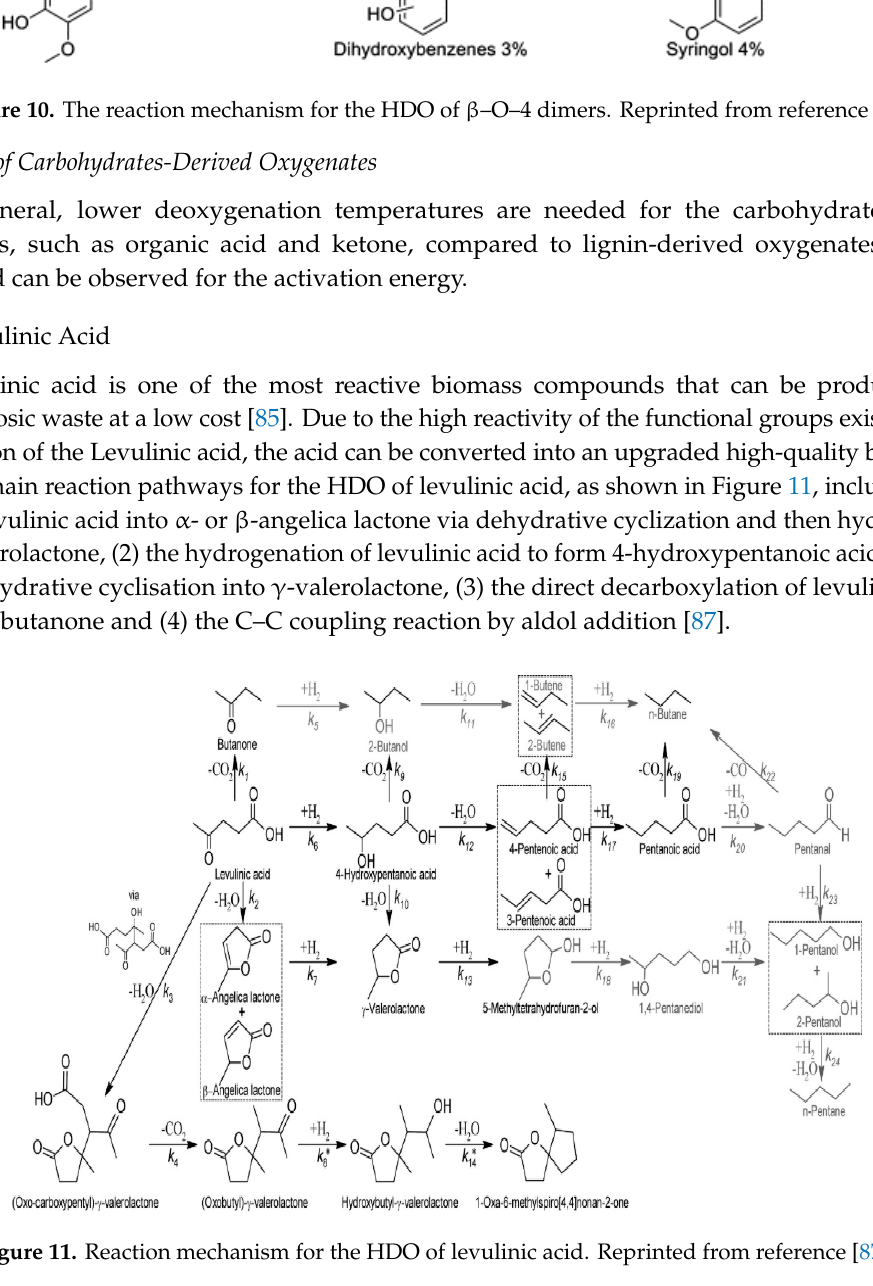
Figure 10. The reaction mechanism for the HDO of β –O–4 dimers. Reprinted from reference [84].